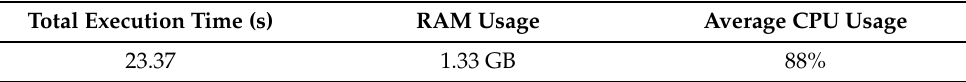
Table 2. The execution metric for 40 runs which generated 64 images of 300 × 300 pixels. Total Execution Time (s)